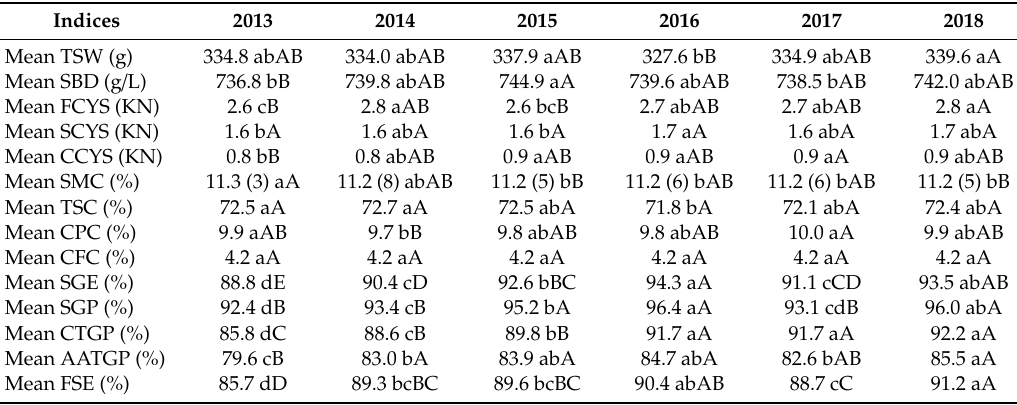
Table 5. Variance analysis for data of maize seed quality indices from 2013 to